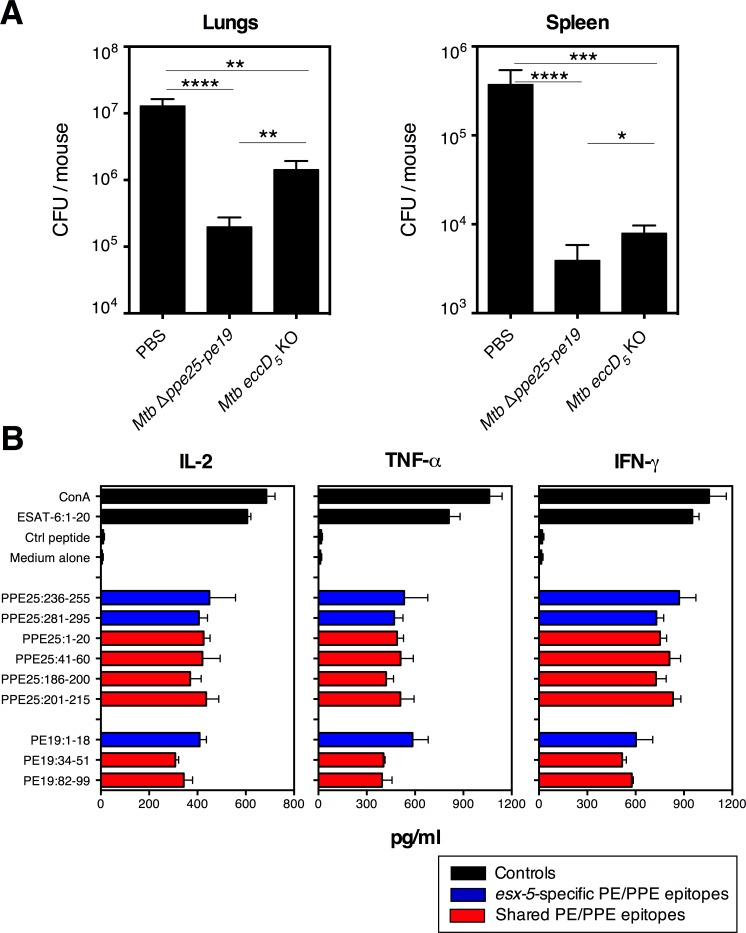
Comparative protective effects of Mtb Δppe25-pe19 or Mtb eccD
5 KO strain and induction of ESX-5-related PE/PPE specific T-cell responses by immunization with synthetic peptides.A) C57BL/6 mice (n = 6 per group), left unvaccinated or immunized s.c. with 1 x 106 CFU/mouse of Mtb Δppe25-pe19 or Mtb eccD
5 KO strain, were challenged at 4 weeks p.i. via aerosol route with ≈ 200 CFU/mouse of Mtb H37Rv WT strain. One month post-challenge, the mycobacterial loads were determined in the lungs and spleen of individual mice. NS = not significant, *, **, ***, **** = statistically significant, as determined by One Way ANOVA test with Tukey’s correction for multiple comparisons, p<0.05, p<0.005, p<0.001 or p<0.0001, respectively. B) IL-2, TNF-α and IFN-γ production, detected in the culture supernatants of splenocytes from mice (n = 3 per group), immunized with individual synthetic PE/PPE peptides formulated in CpG(DOTAP) at 10 days p.i. Error bars represent ± SD. The results are representative of two independent experiments.